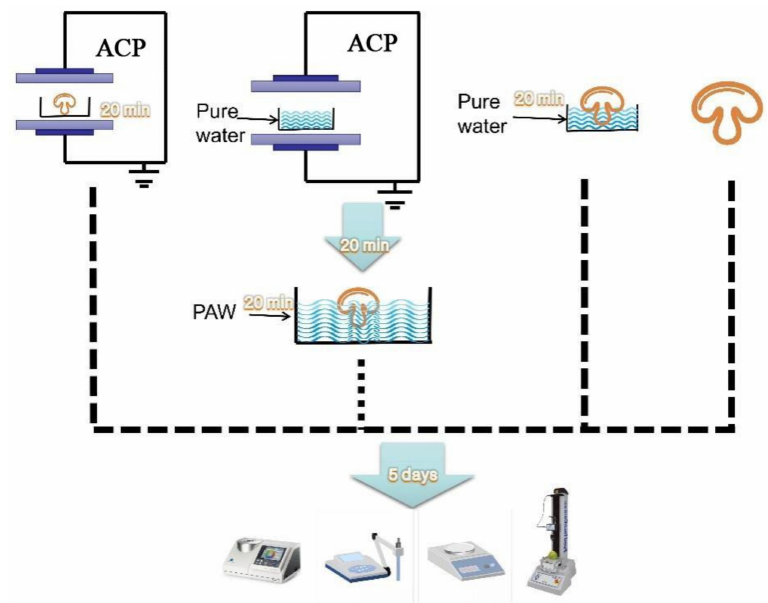
Figure 1. The study was divided into four groups, from left to right: ACP generation by dielectric barrier discharge plasma equipment to directly treat button mushrooms (DBD); Plasma-activated water generation by dielectric barrier discharge plasma equipment to soak button mushrooms (PAW); Pure water directly soak button mushrooms (PW); untreated button mushrooms